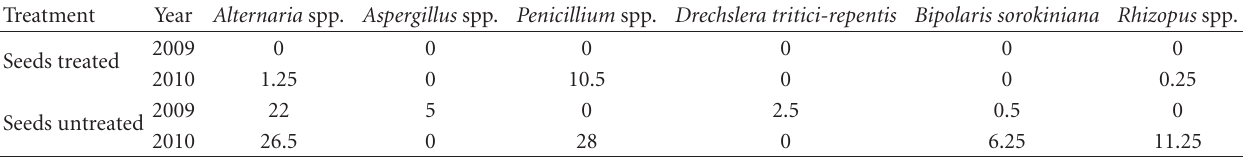
Table 1: Incidence (%) and genera of pathogens identified through blotter tests of seeds treated with fungicide or untreated in 2009 and 2010.